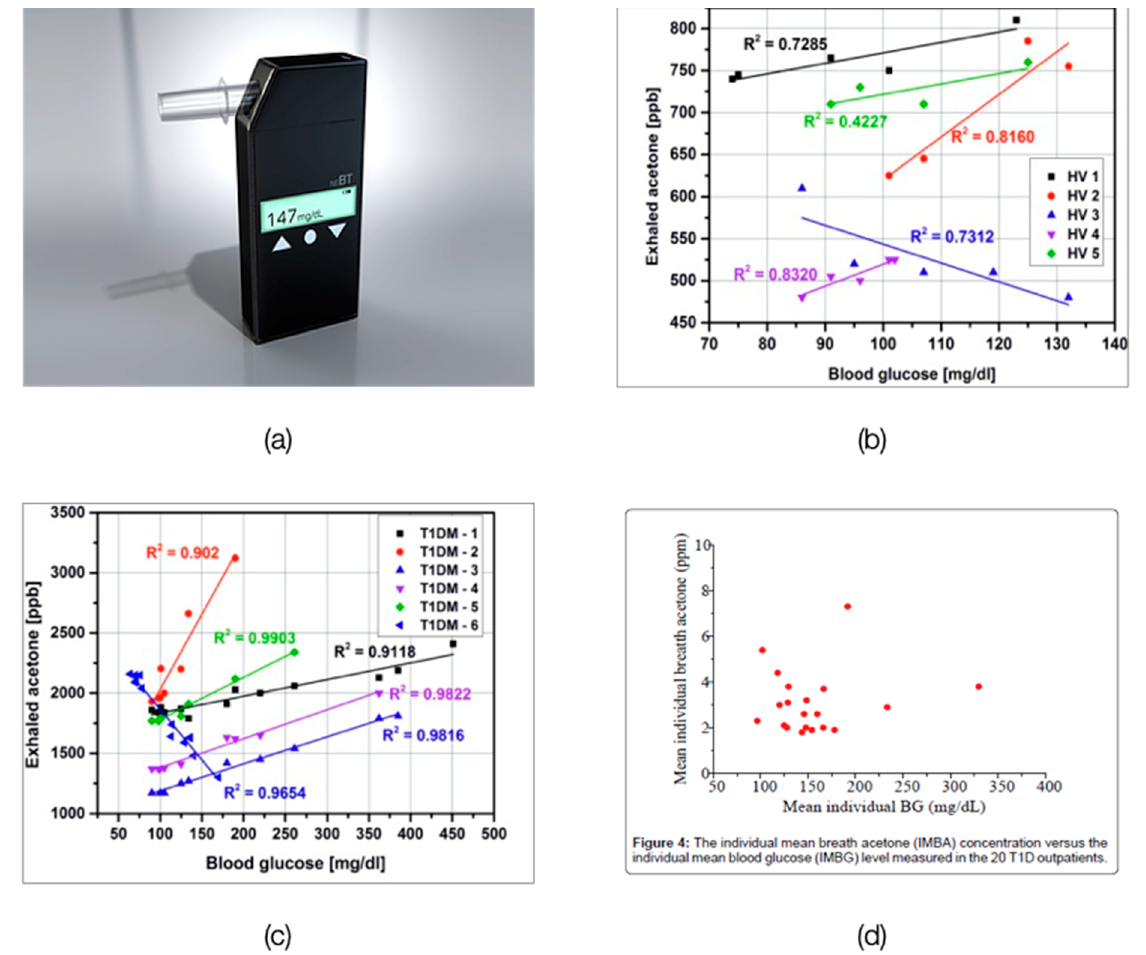
Figure 4. ( a ) Glucair: Pain-Free Diabetic Glucose Breath Detector. Reprinted with permission from Breath Health Inc. [67] ( b , c ): Relation between breath acetone as measured by mass spectrometry and blood glucose ( b ) Healthy Volunteers [68] ( c ) TIDM subjects [68] ( d ) The individual mean breath acetone concentration versus the individual mean blood glucose (IMBG) level measured in the 20 T1DM outpatients (no strong correlation) [69].